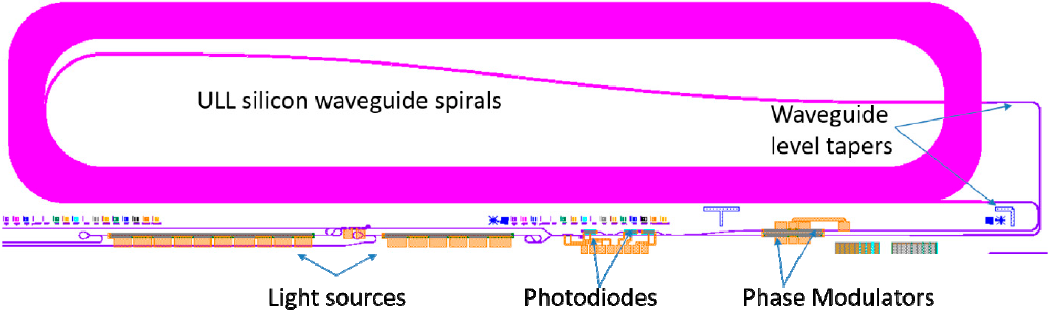
Figure 10. Schematic mask layout of an integrated interferometric optical gyroscope on heterogeneous silicon photonics. The sensing part of the gyroscope is the four-meter long ULL silicon waveguide spiral with propagation loss ~4 dB/m. The sensing coil waveguides were connected with a compact integrated optical driver ([10]) via tapers to standard and compact waveguides.